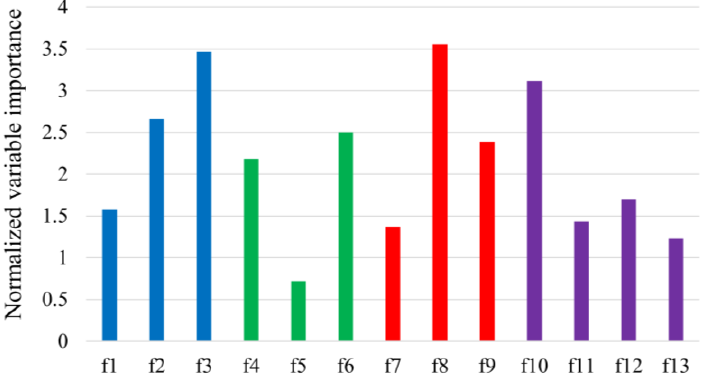
Figure 3. Normalized RF variable importance for extracted features from the FP SAR data (July 21).